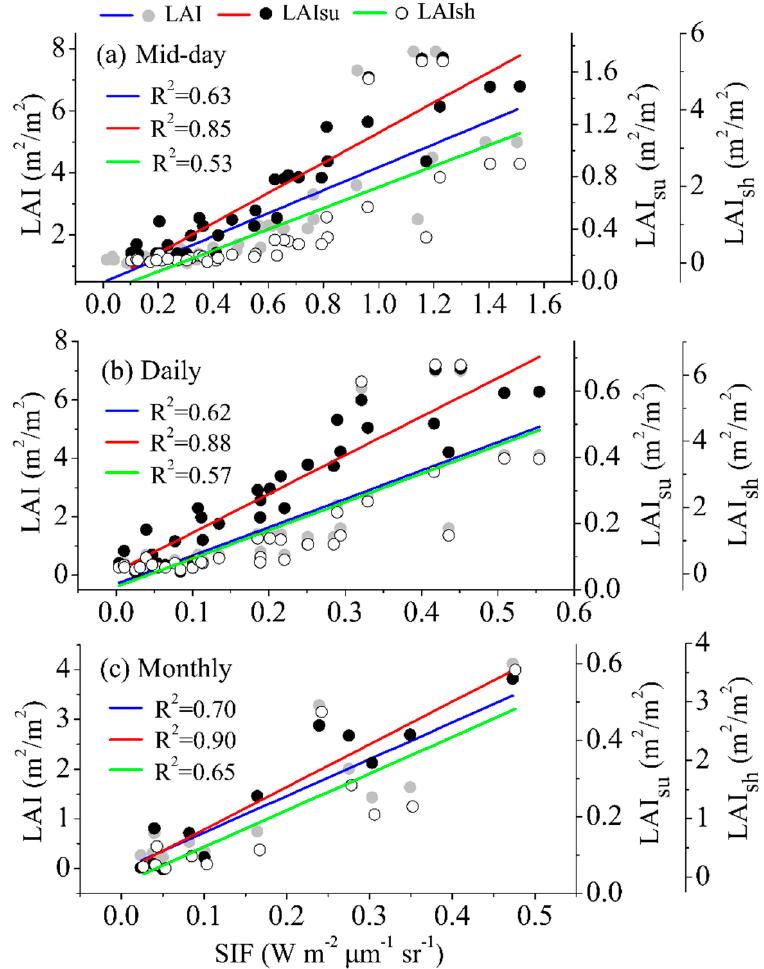
Figure 8. Scatterplots of the solar-induced chlorophyll fluorescence (W m − 2 µ m − 1 sr − 1 ) and sunlit / shaded / total leaf area index (LAI su , LAI sh , LAI, m 2 / m 2 ) on the mid-day, daily, and monthly timescales, respectively.